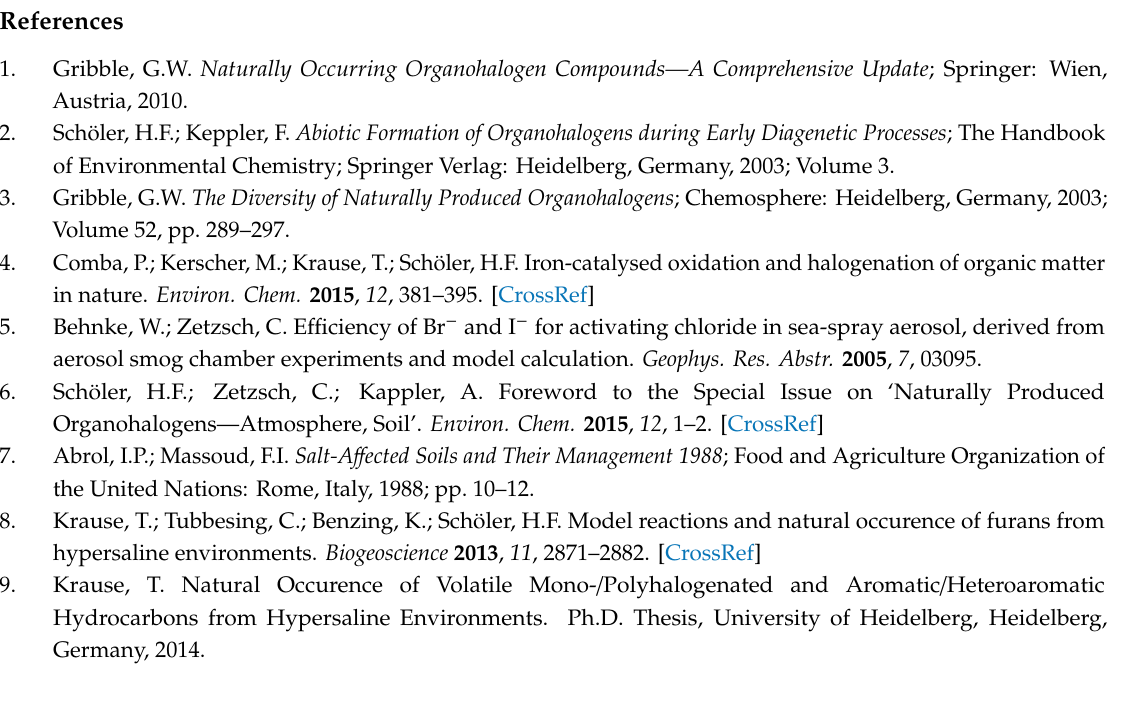
Figure S1: Measured compounds of lakes Orr, Kathleen, Bean and Strawbridge, Figure S2: Source / Sink strengths chloroacetone Lake Bean, Figure S3: Source / Sink strengths bromoacetone Lake Bean, Figure S4: Source fraction of chloroacetone formation Lake Bean, Figure S5: Source fraction of bromoacetone formation Lake Bean, Figure S6: Source / Sink strengths chloroacetone Lake Shot, Figure S7: Source / Sink strengths bromoacetone Lake Shot, Figure S8: Source fraction of chloroacetone formation Lake Shot, Figure S9: Source fraction of bromoacetone formation Lake Shot, Figure S10: UV-spectra of bromoacetone and 1,1-dibromoacetone, Figure S11: Foto of the chamber on Lake Shot, Figure S12: Foto of the cover area by the chamber on Lake Shot, Table S13: Measured MR on the lakes, Figure S14: Measured propene, methacrolein, chloro- and bromoacetone mixing ratios at Lake Shot, Figure S15: Modeled time profiles of the concentrations of atomic Cl and Br, chloro- and bromoacetone and propene and methacrolein for the conditions at Lake Shot, Figure S16: Comparison of the unknown source strength of chloroacetone with the photochemical gas-phase sources of halogenation of propene and methacrolein as a function of atomic Cl, FACSIMILE File S17: fit_shot16-19E8_br.fac and FACSIMILE File S18: